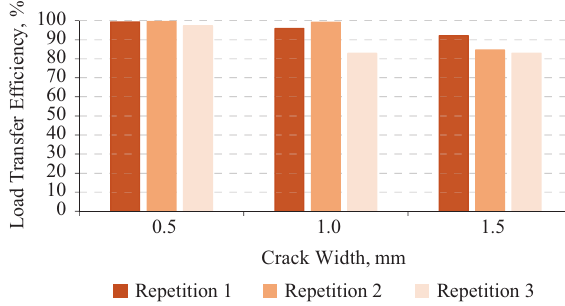
Figure 4. Load Transfer Efficiency behaviour with Crack Width for aggregates 10